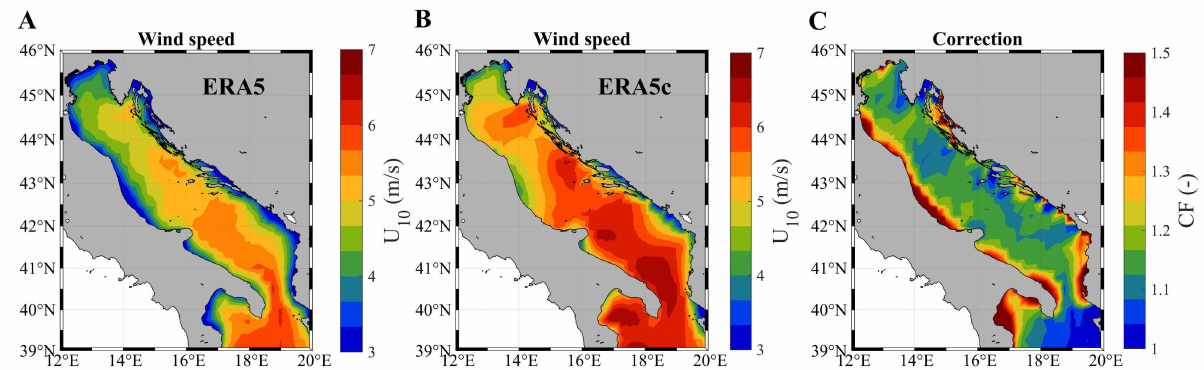
Figure 8. Statistical correction of historical (1981–2010) ERA5 wind speed ( U 10 , in m/s, hourly) over the Adriatic Sea and the northern Ionian Sea. 30-year average from ERA5 ( A ), 30-year average from ERA5c ( B ), and weighted average of the nondimensional correction factor CF ( C